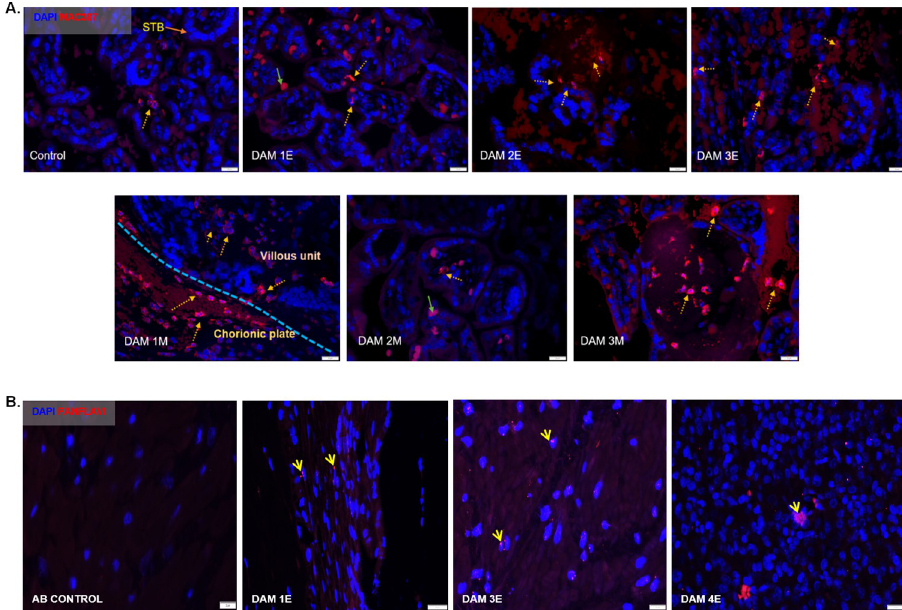
staining in the uterus. (Scale bar = 20 μ